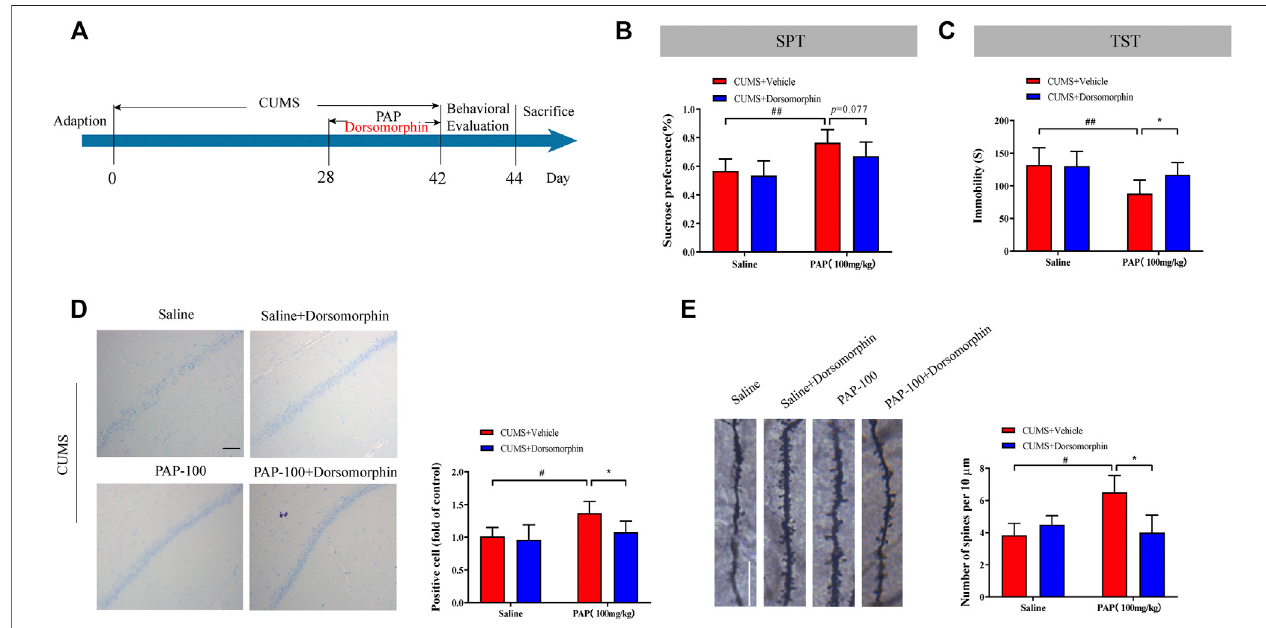
FIGURE 6 | Role ofAMPK in the attenuation of PAP on CUMS-induced depression. The schedule of CUMS induction and drug treatment in experiment 3 (A) . The sucrose preference in the SPT (B) . The immobility in TST (C) . The positive cell in Nissl staining (D) and the number of spines per 10 μ m 2 (E) of Golgi-Cox staining. * p <